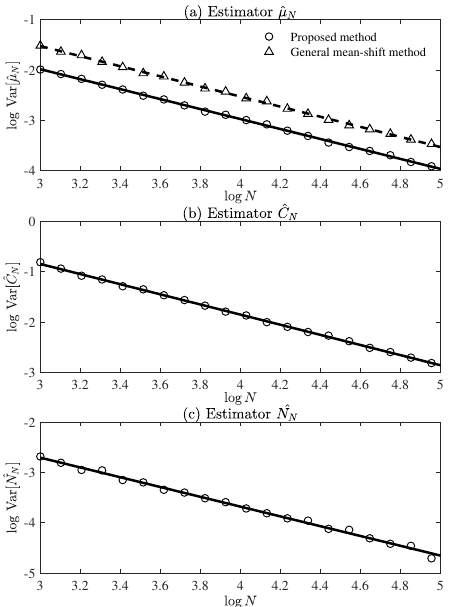
Figure 7. Variance of the estimates ˆ µ N , ˆ C N , ˆ N for various numbers N of samples in the proposed method and the general mean-shift